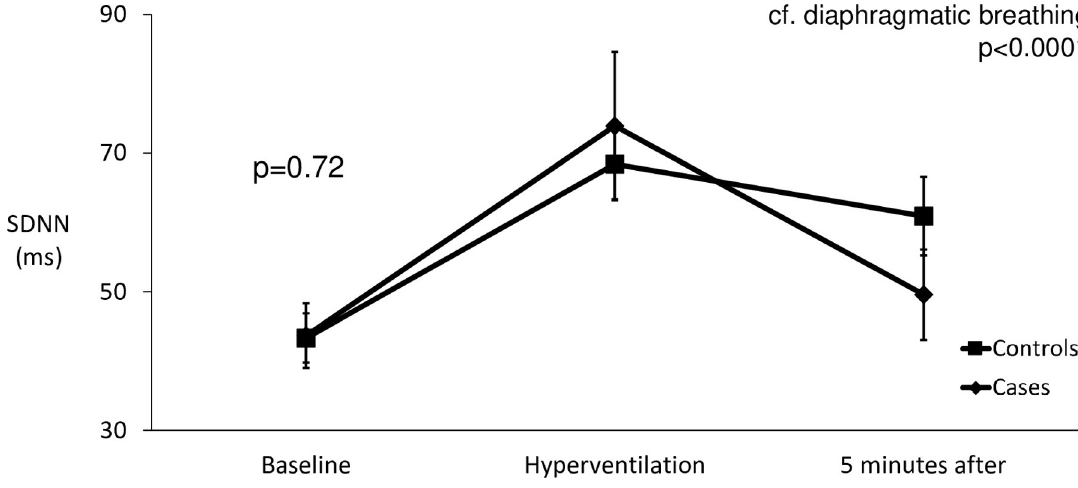
Fig 7. The effects of hyperventilation on SDNN in cases and